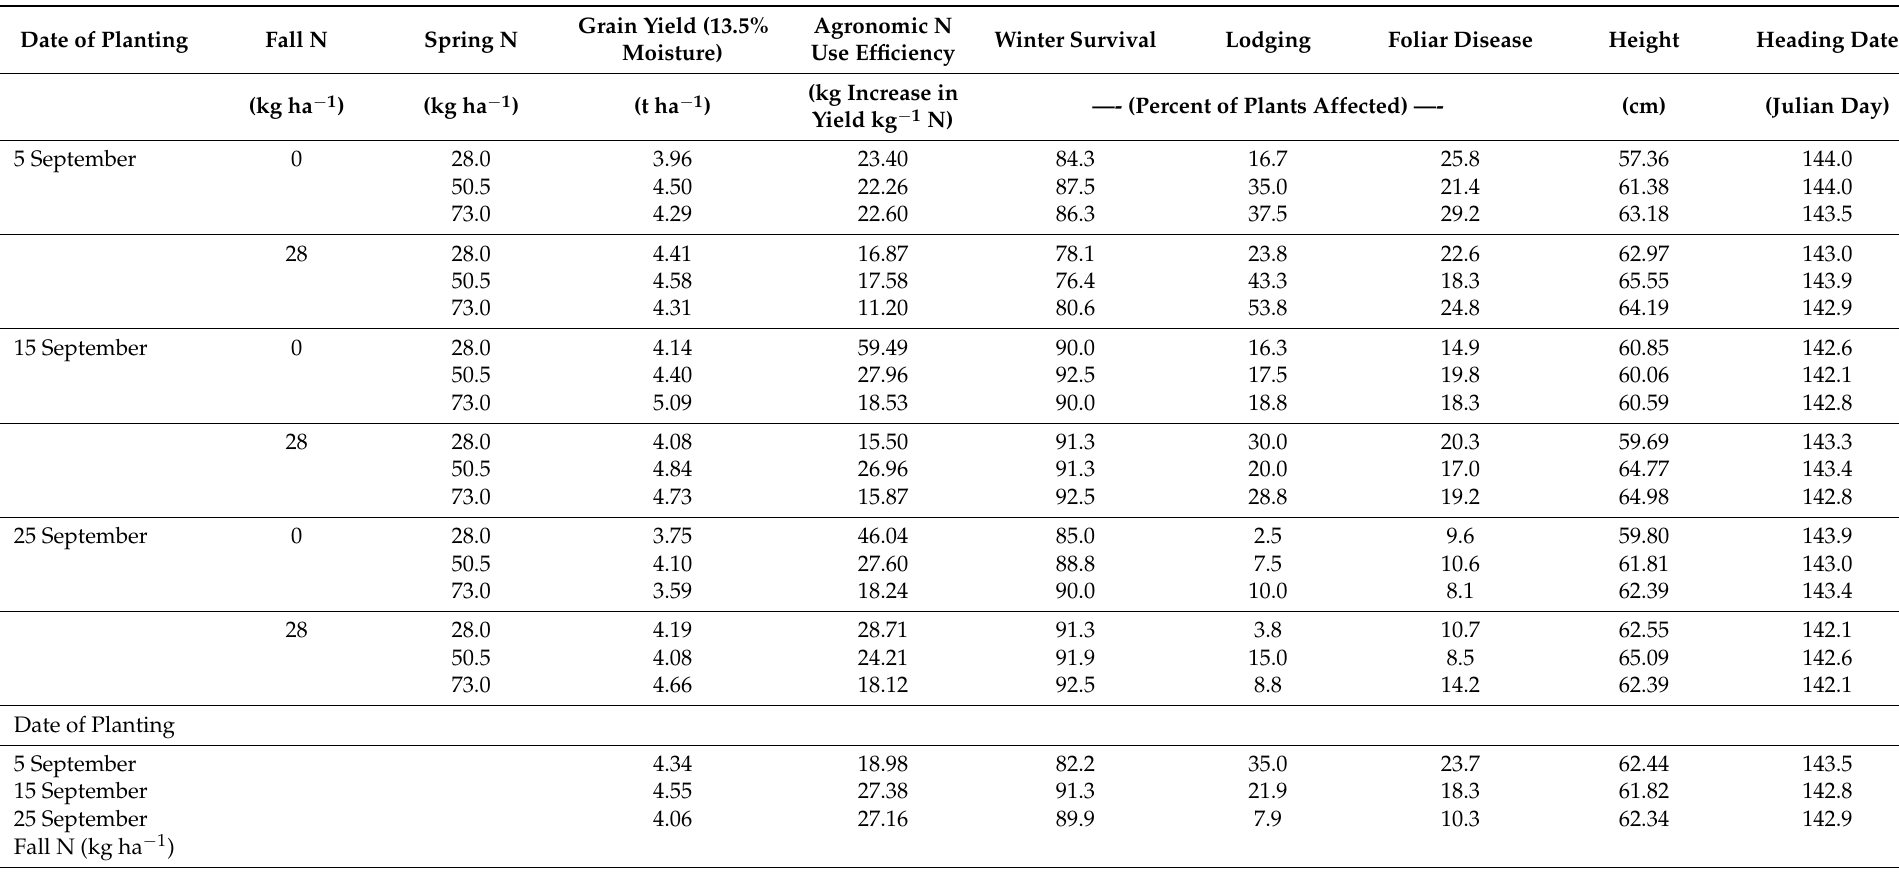
Table 2. Mean yield and growth metrics for winter malt barley grown with different dates of planting and fall and spring N rates grown in South Deerfield MA in 2014–2015 and 2015–2016. Date of